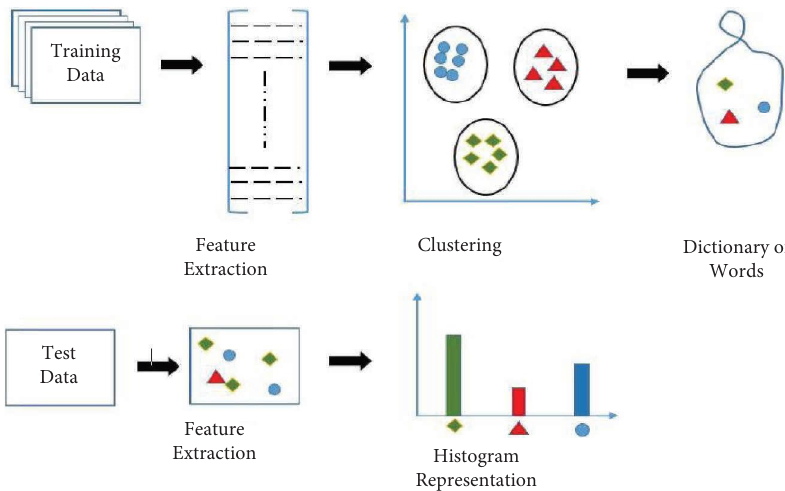
Figure 4: Illustration of the bag-of-words (BoVW) model.